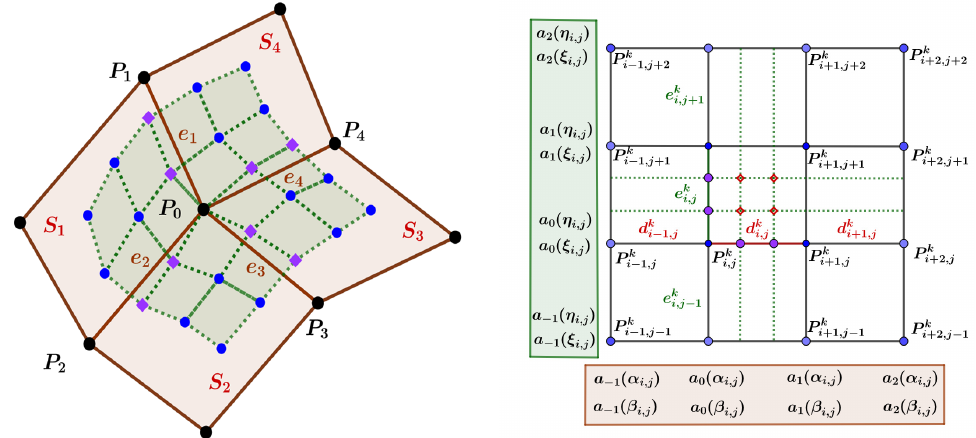
Figure 4. Left: notation for the initial mesh (consists of black dots ( P 0 , P i ), solid lines ( e i ), and light- pink shaded quadrilateral faces ( S i , i = 1,2,3,4)) and the new mesh after refinement (consists of P 0 new edge points (purple diamonds), new face points (blue dots), dotted lines, and light-green shaded quadrilateral faces). Right: the mask parameters of the interpolation points in the horizontal and vertical directions.